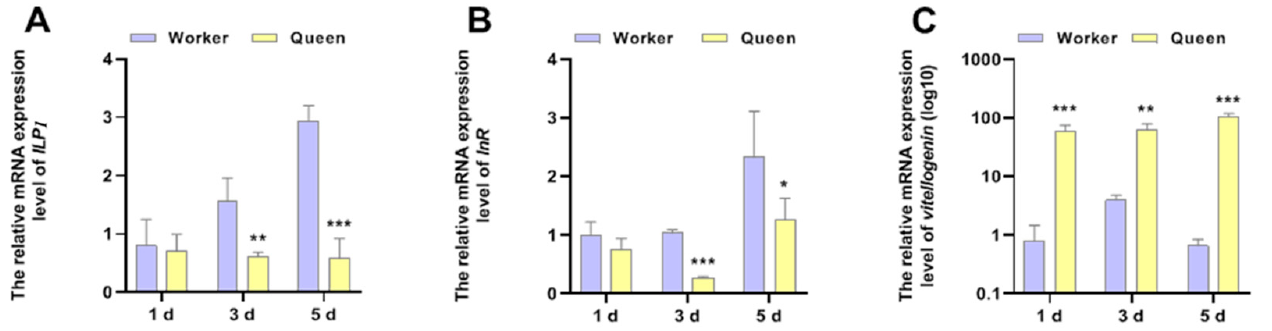
Figure 3. The mRNA expressions of ILP1, InR and vitellogenin. * represents p < 0.05, ** represents p < 0.01, *** represents p < 0.001, N queen = 9, N worker =